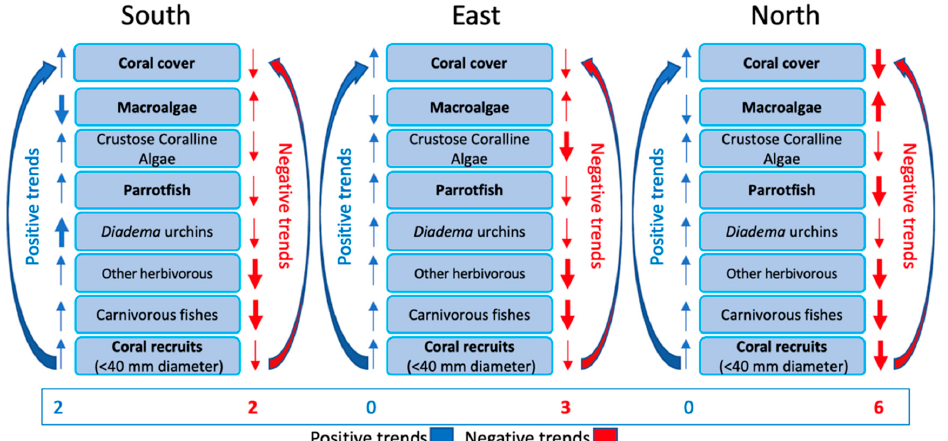
Figure 12. Trends in major coral reef drivers (good condition or positive on left in blue; poor condition or negative on right in red) were evaluated using the monitoring protocol from [25]. Most important reef characteristics are in boldface. North Sector DR reefs were clearly trending most negatively, possibly because of multiple stresses (coral bleaching, hurricanes, and overfishing).